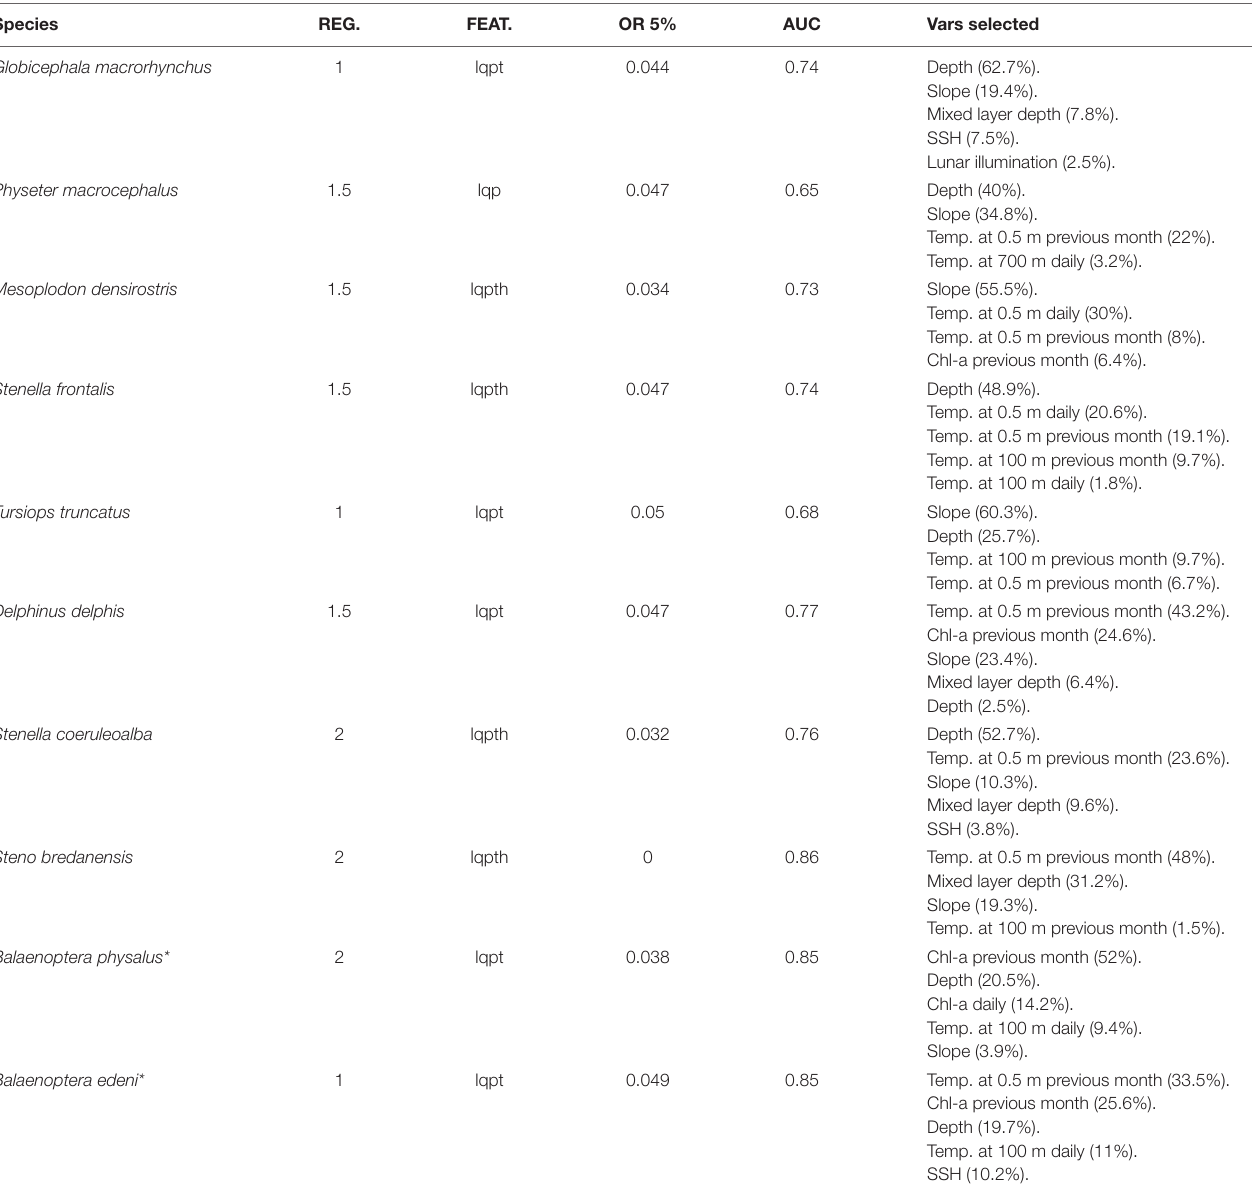
TABLE 4 | Daily models regularization multiplier (REG.), feature classes (linear = l, quadratic = q, product = p, threshold = t, and hinge = h), omission rate at 5% (OR 5%), area under the curve (AUC), and variables selected (with its contribution) for each species. Species REG.